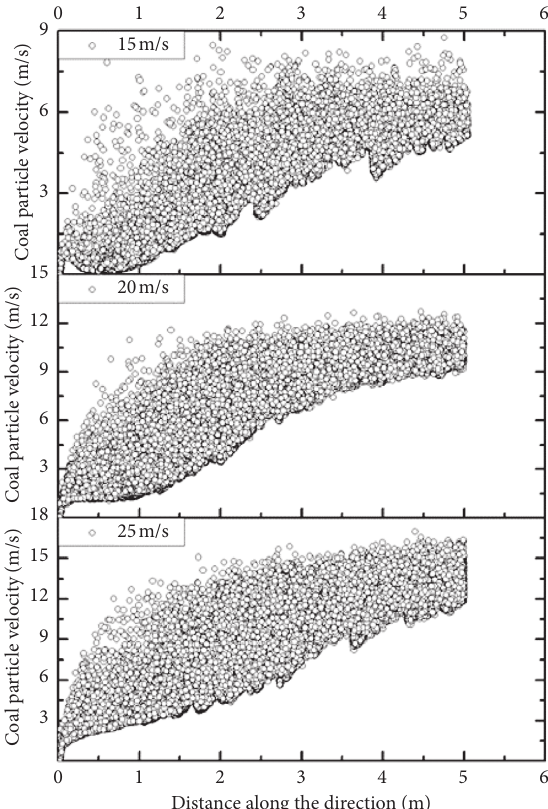
Figure 14: Particle velocity distribution along the flow direction with particle generation rate of 0.04kg/s ( t �